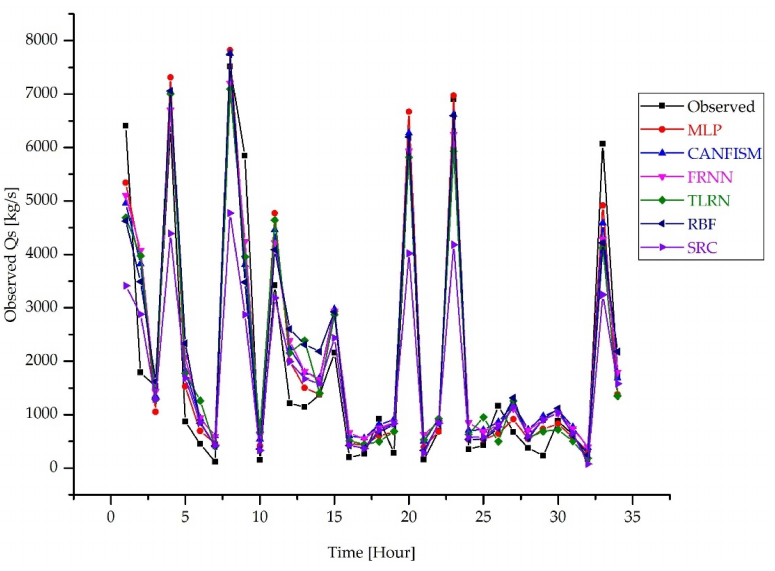
Figure 13. Observed and estimated sediment discharge during the testing stage. Table 6. The comparison of peak estimations of the different models in the test